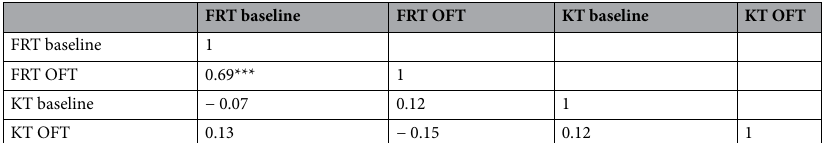
FRT baseline FRT OFT KT baseline KT